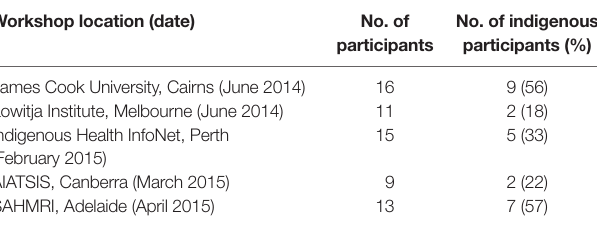
TaBle 2 | indigenous research impact tool development workshops. Workshop location